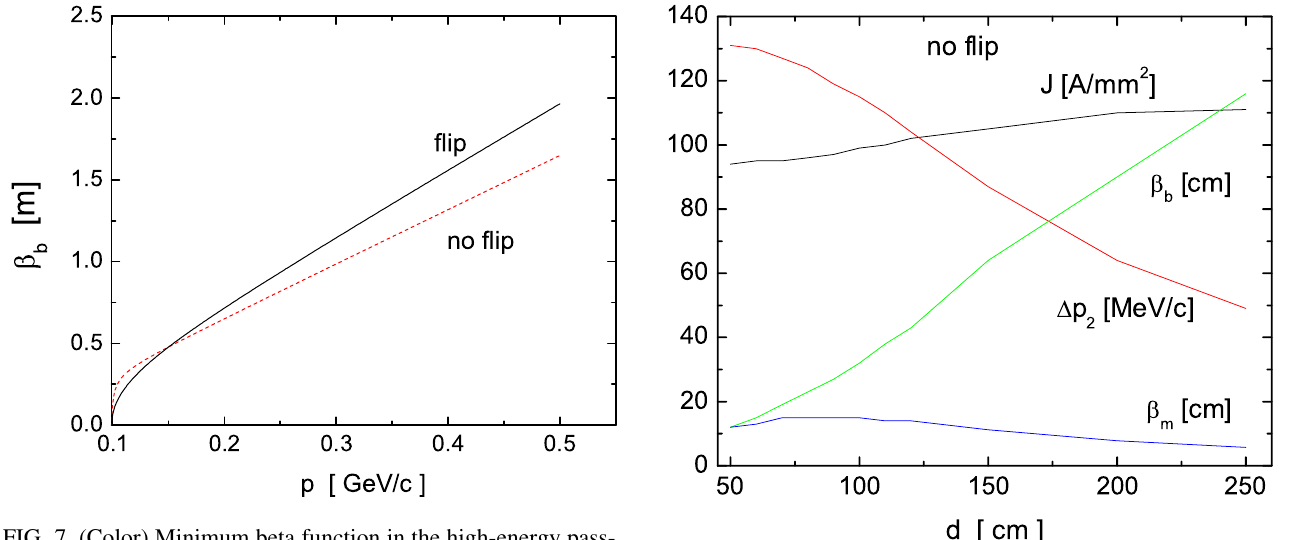
FIG. 7. (Color) Minimum beta function in the high-energy pass- band versus momentum. The minimum value occurs at the cell boundary. FIG. 8. (Color) Lattice parameters as a function of the cell